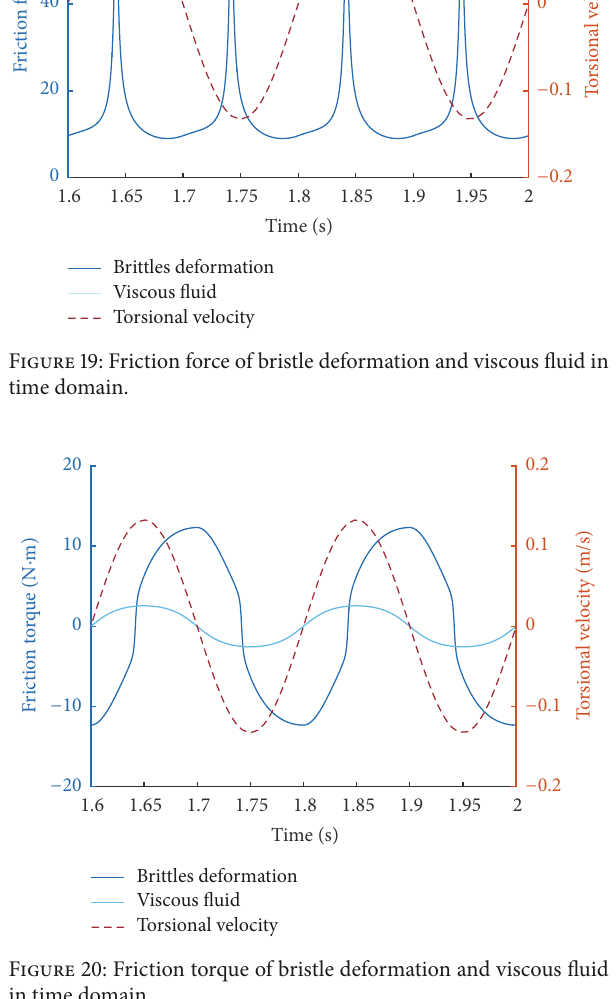
Figure 20: Friction torque of bristle deformation and viscous fluid in time